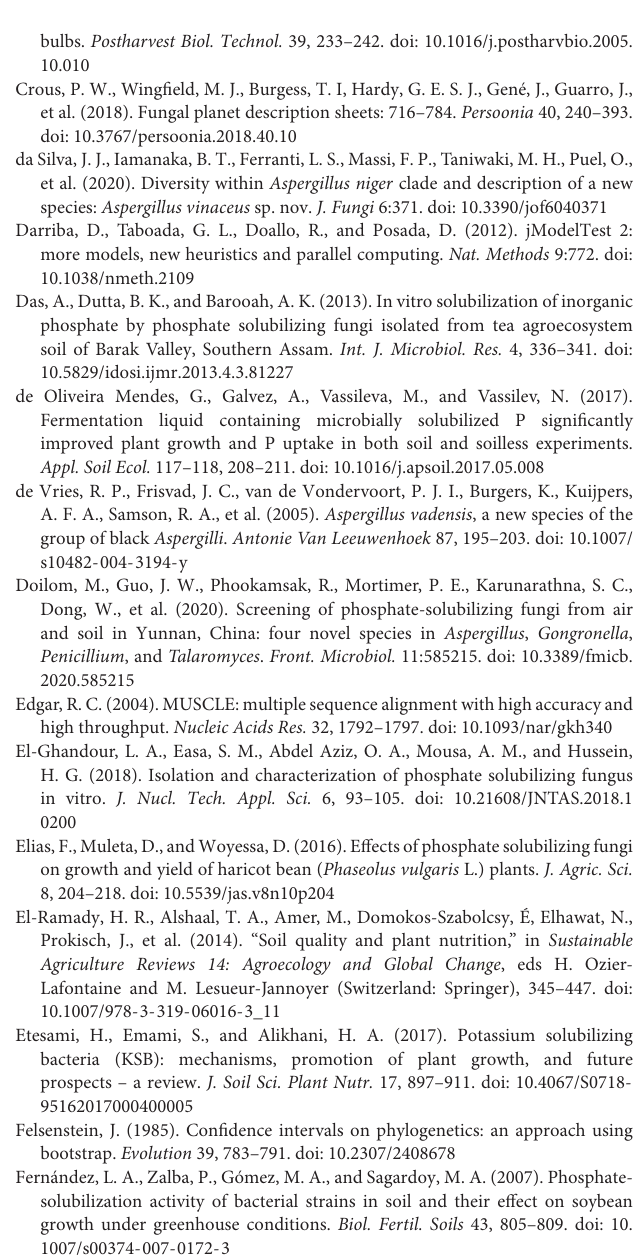
Supplementary Figure 1 | HPLC chromatograms of onion bulb for quantification of quercetin. (A) quercetin standard, (B) extract of onion in T1, (C) extract of onion in T2, (D) extract of onion in T3, (E) extract of onion in T4, (F) extract of onion in T5, (G) extract of onion in T6, (H) extract of onion in T7, (I) extract of onion in T8. Supplementary Table 1 | Details of sequences used for phylogenetic analysis.